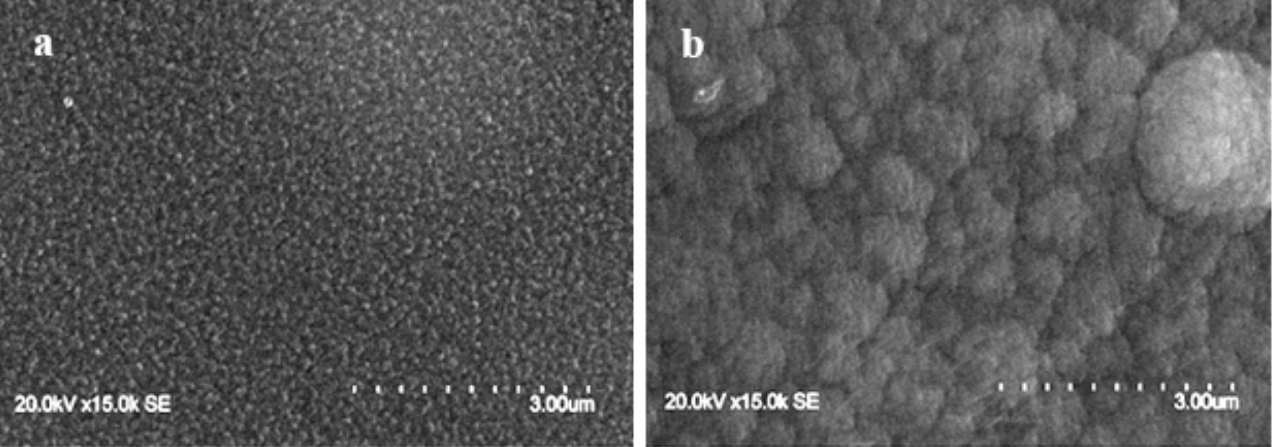
Figure 3. Scanning electron microscopy (SEM) images of boron coatings on sample surfaces ( a ) after deposition on the substrate and ( b ) after processing with electron beam pulses in regime 1 at a peak current of 20 A and an electron energy of 8 keV.